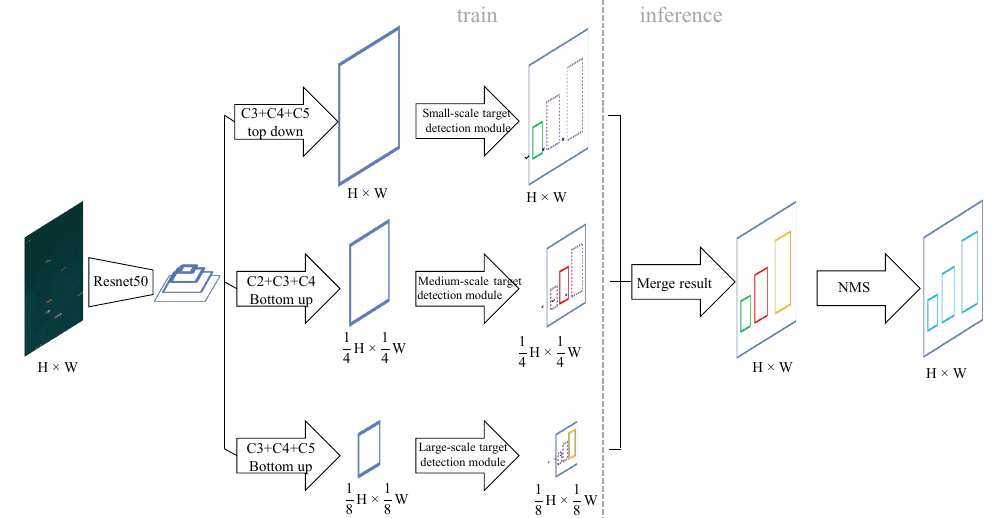
Figure 4. An overview of the hierarchical scale sensitive